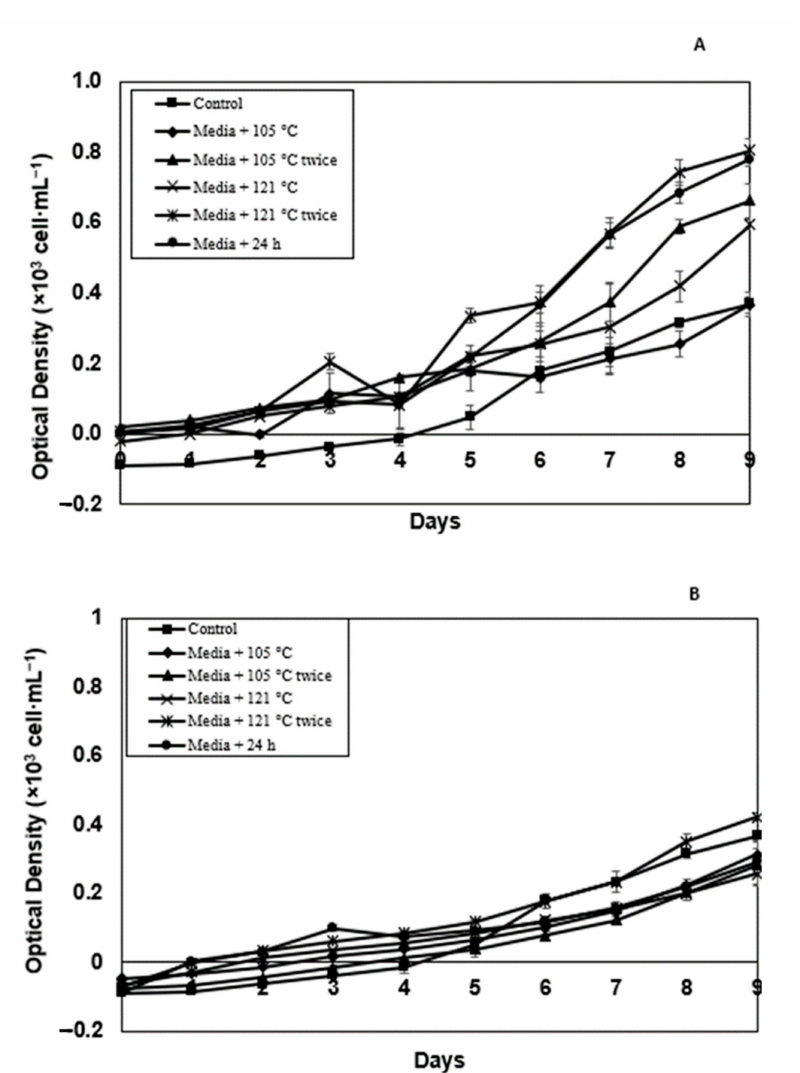
Figure 6. Optical density at 680 nm of C. vulgaris in control, media + 105 ◦ C, media + 105 ◦ C twice, media + 121 ◦ C, media + 121 ◦ C twice and media + 24 h (media + 105 ◦ C—autoclave 105 ◦ C; media + 105 ◦ C twice—autoclave 105 ◦ C 2 × after natural extraction 24 h; media + 121 ◦ C—autoclave 121 ◦ C after natural extraction 24 h; media + 121 ◦ C × 2—autoclave 121 ◦ C twice after natural extraction 24 h; media + 24 H—natural extraction for 24 h). ( A ) RM SE and ( B ) AH SE. Error bars represent standard deviation ( n =